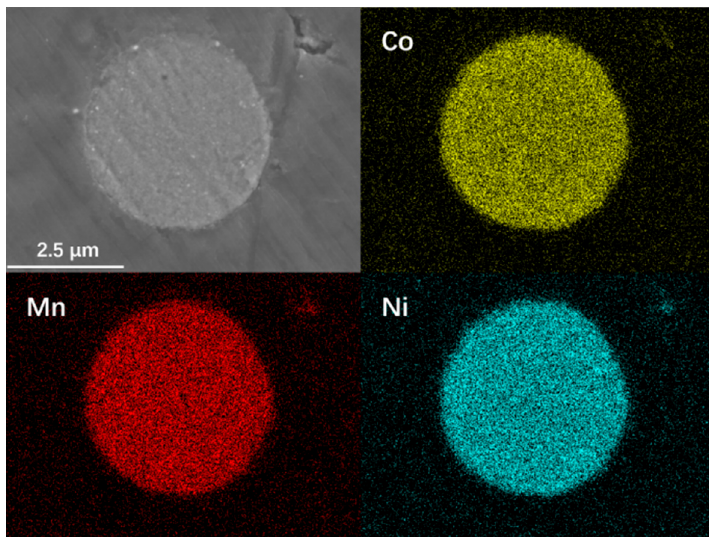
Figure 3. SEM-EDX mapping photographs for Ni, Co, and Mn in products after hydrothermal treatment. R M = 1:1:1 (Ni:Co:Mn); C M = 0.15 mol·L − 1 ; C (NH4)2CO3 = 0.15 mol·L − 1 ; T h = 180 °C; t h = 24 h.